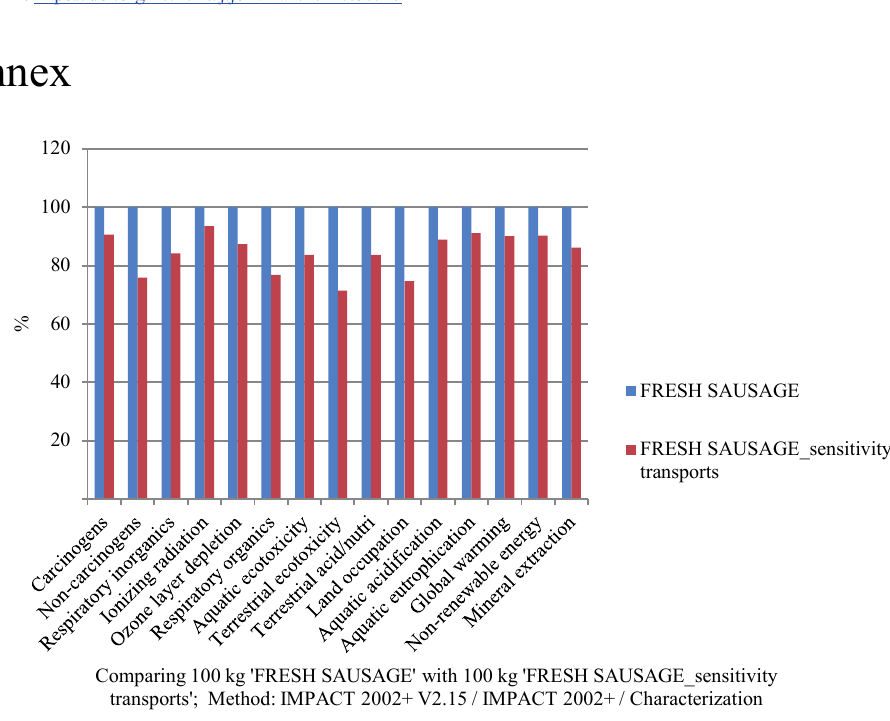
Fig. A1. Sensitivity analysis results considering a variation of transport